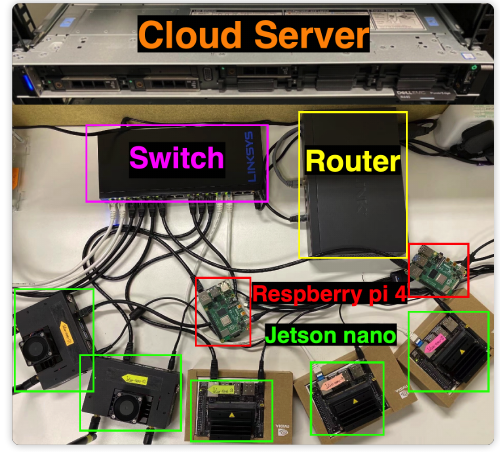
Figure 4. Experiment